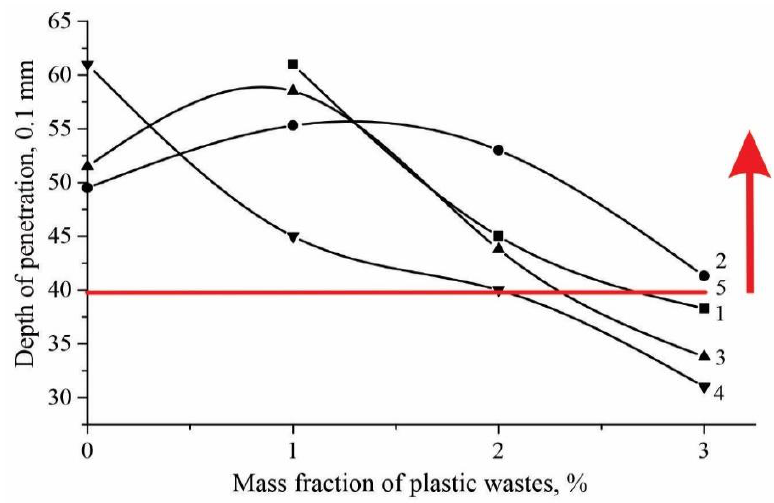
Figure 4. Change in penetrations from polymer waste concentrations. 1—without SBS; 2—SBS 1%; 3—SBS 2%; 4—SBS 3%; 5—according to Standard.